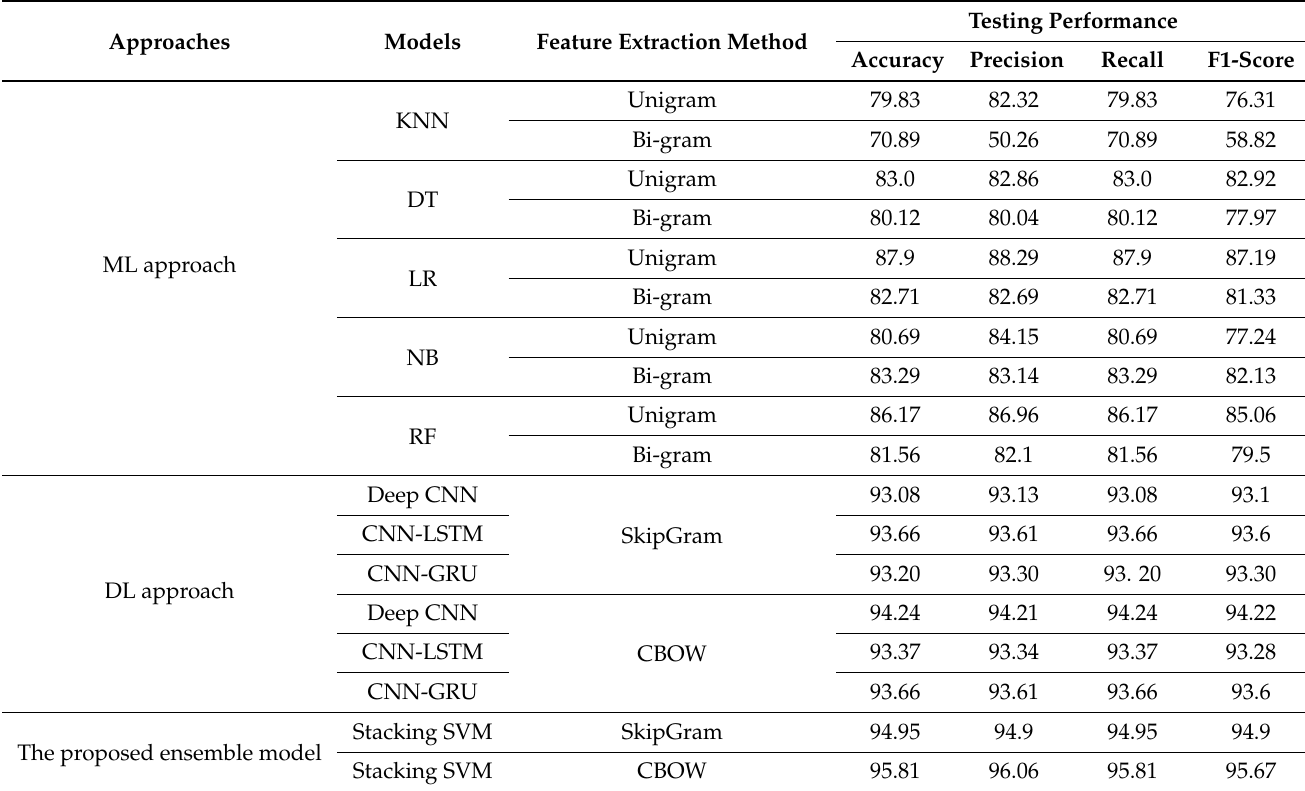
Table 5. The performance results of models for the Sub-AHS